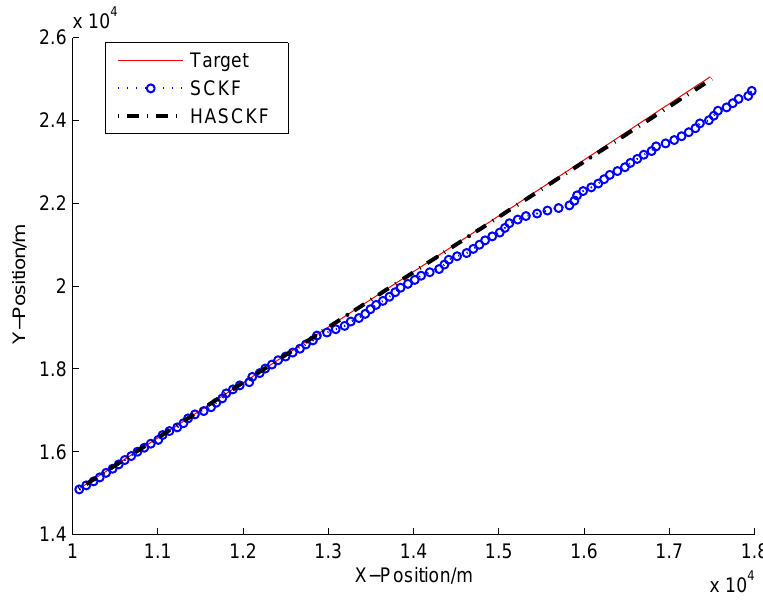
Figure 6. Target’s trajectory and tracking result of SCKF and HASCKF.